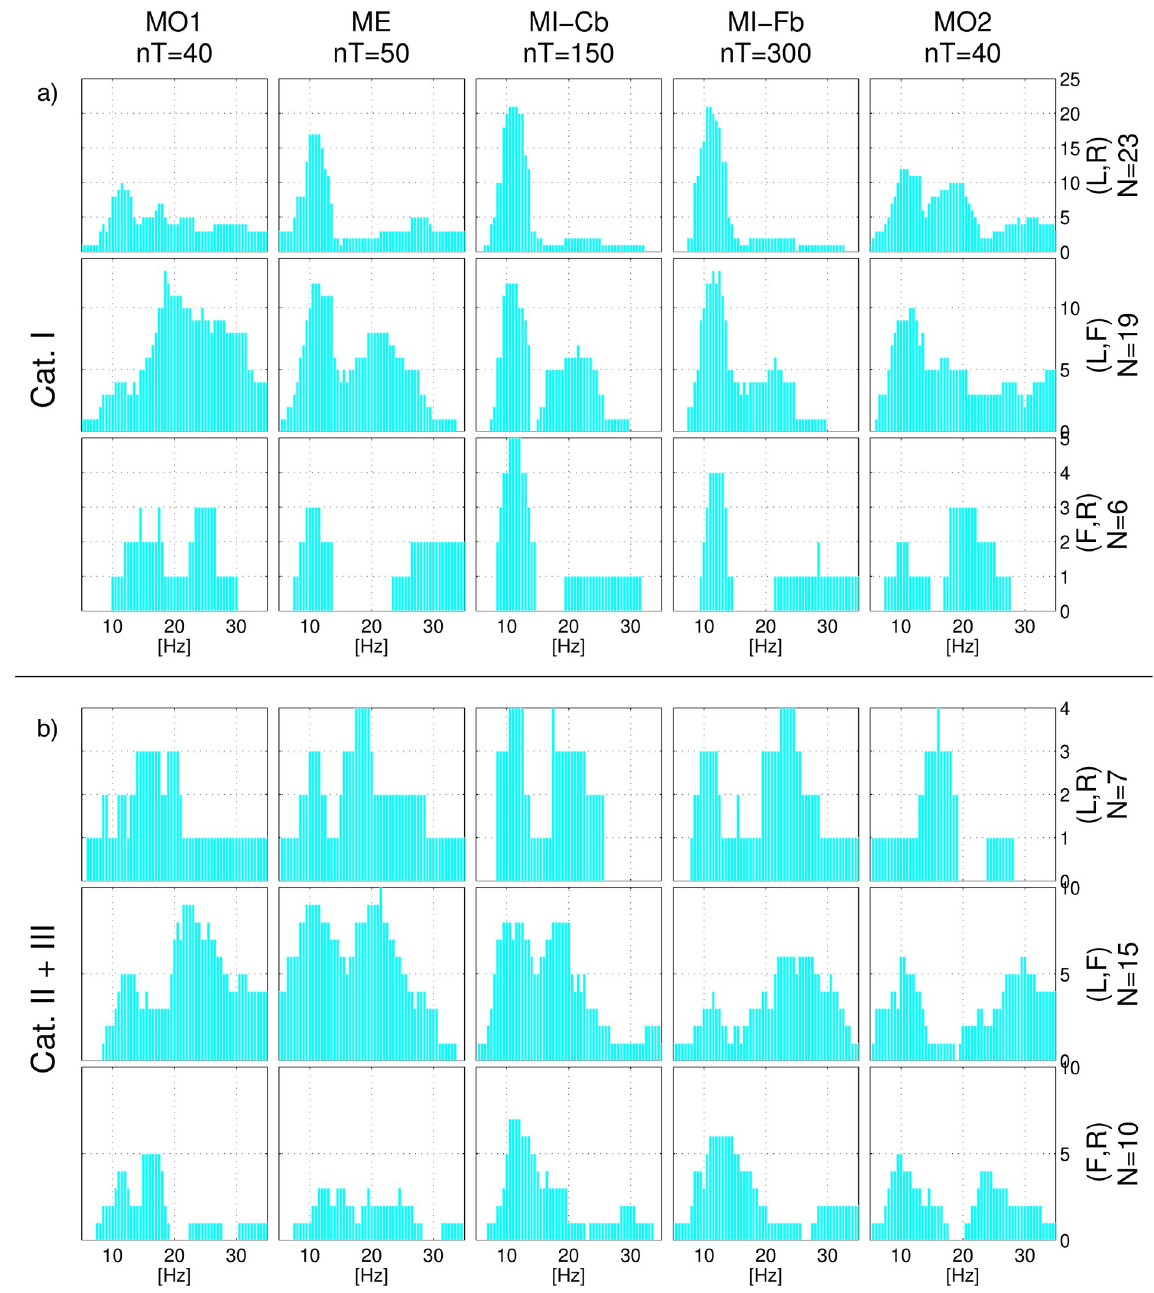
Fig 6. Histogram of reactive frequency bands. For each frequency bin, the histogram indicates the number of users for whom the frequency belonged to the subject-specific frequency band. From left to right, the different tasks/runs. Panel a) corresponds to Cat. I users and panel b) to Cat. II and III participants. In each panel from top to bottom, the three class combinations Left/Right , Left/Foot and Foot/Right .